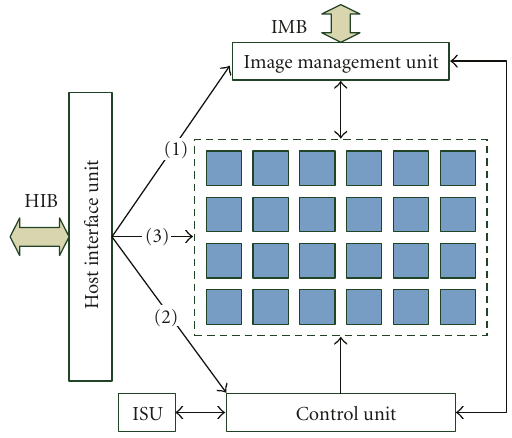
Figure 17: (a) The absence of neighbors is salvaged by adding a single layer of virtual nodes. (b) For boundary nodes more than one layer of virtual nodes is needed.